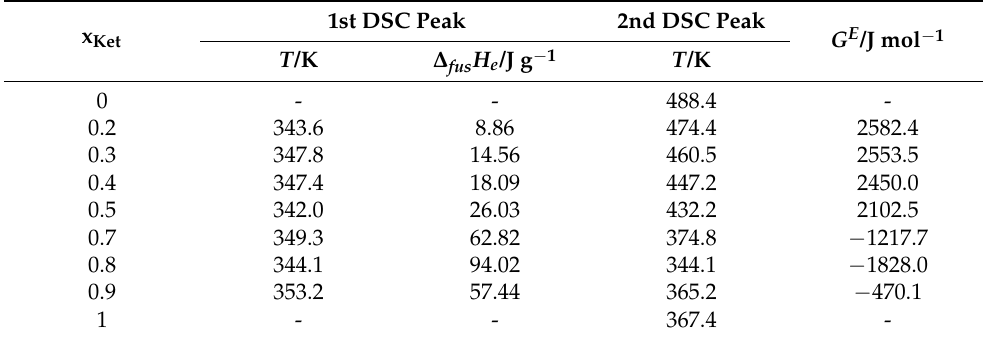
Figure 5. DSC curves for Ket and D-HCl and their binary mixtures. The eutectic composition of binary mixture Ket—D-HCl corresponds to a molar fraction of 0.8 Ket, having a melting temperature of 344.1 K and a melting enthalpy of 94.02 J g − 1 . x Ket Table 3. Thermodynamic parameters for Drotaverine Hydrochloride and Ketoprofen system